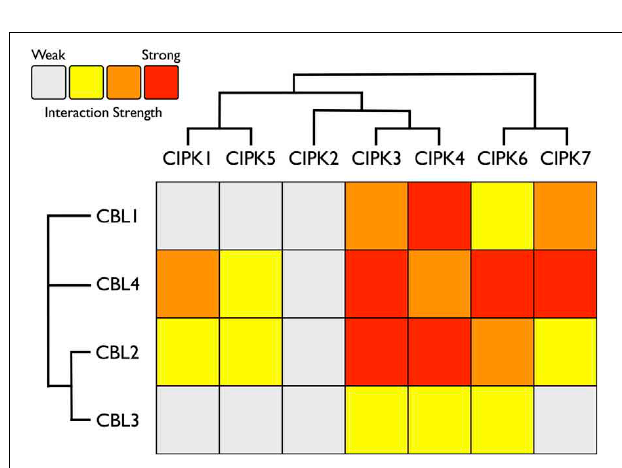
FIGURE 7 | Heat map summarizing yeast two-hybrid (Y2H) results for all Physcomitrella CBL and CIPK combinations. Each CBL and CIPK was fused to activation domain (AD) or DNA-binding domain (BD) of a split transcription factor and screened for interactions between CBL-AD/CIPK-BD fusion proteins and CBL-BD/CIPK-AD fusions. Interaction strength was inferred by serial growth dilutions on selective media lacking one or two auxotrophic markers and summarized qualitatively by heat map. Red boxes indicate vigorous growth on -LTHA plates (see Materials and Methods); orange boxes indicate weaker growth on -LTHA plates. Yellow boxes indicate robust growth on -LTH plates but no growth on -LTHA plates. Gray boxes indicate weak growth on -LTH plates, but each CBL-CIPK interaction conferred better growth than the empty vector (EV) control. Representative images of each assay are shown in Supplementary Figure S3. Inferred phylogenetic relationships of Physcomitrella CBLs and CIPKs are indicated by cladogram and described in the main